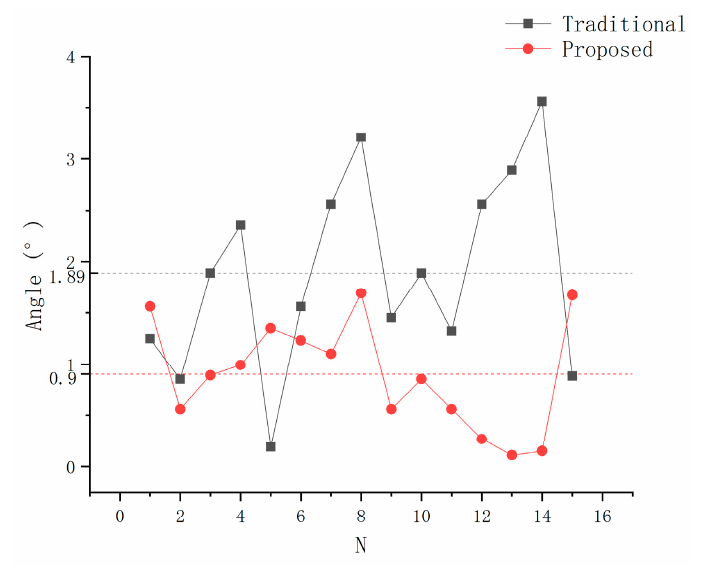
Figure 18. Comparison TCPF error.